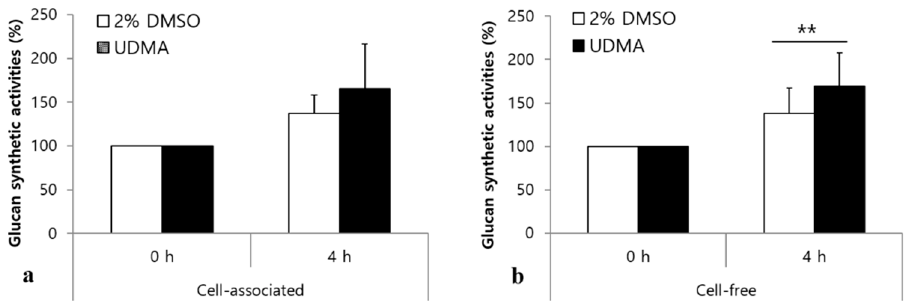
Figure 6. Glucan synthesis activity of S. mutans UA159 lacking the ftf gene in the presence and absence of UDMA. The relative cell-associated glucan synthesis activity ( a ) was measured in homogenized cell pellets, and the relative cell-free glucan synthesis activity ( b ) was measured in the cellular supernatant. The percentage activities were calculated using the activity at time zero as 100%. DMSO was used as a vehicle for UDMA, and cells grown in the absence of UDMA (2% DMSO) were used as the control. The data are expressed as mean ± standard deviation values. ** p < 0.01; repeated measure ANOVA.